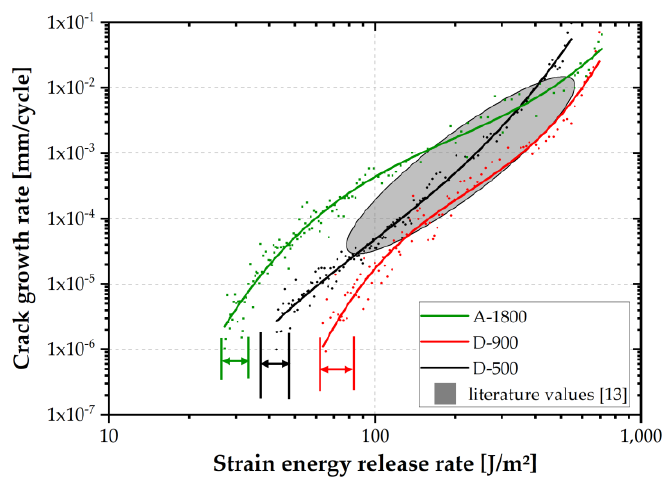
Figure 9. Crack kinetic curves at ambient temperature of laminates made from epoxy varnishes with EEW values of 500, 900 and 1800 g/mol compared to values from the literature [13], marked in grey.